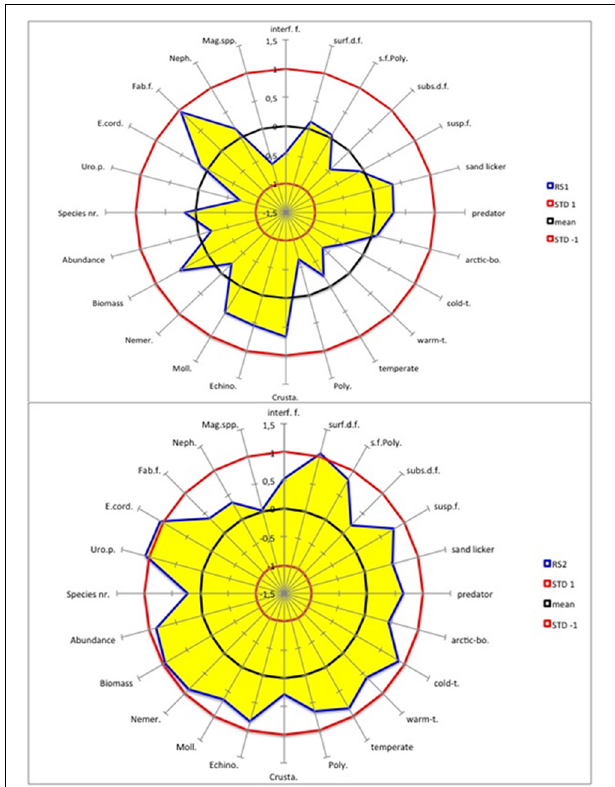
FIGURE 4 | AMOEBA model for the southern North Sea benthos (blue line as the edge of the yellow area). Two regime shifts (RS) are shown. RS1 shows the differences in the standardized spring values of the regime 1989–2000minus those of 1977–1988 (upper panel) . RS2 shows the differences in the standardized spring values of the regime 2001–2012minus those of 1989–2000 (lower panel) . The black circle marks the long-term climatic mean value, and the two red circles the ± 1 STD. The acronyms are in clockwise direction: Interface-feeders (interf.f.), surface-deposit-feeders (surf.d.f.), sediment-feeding polychaeta (s.f.Poly.), subsurface-deposit-feeders (subs.d.f.), suspension-feeders (susp.f.), arctic-boreal (arctic-bo.), cold-temperate (cold-t.), warm-temperate (warm-t.), Polychaeta (Poly.), Crustacea (Crusta.), Echinodermata (Echino.), Mollusca (Moll.), Nemertini (Nemer.), Urothoe poseidonis (Uro.p.), Echinocardium cordatum (E.cord.), Tellina (Fabulina) fabula , (Fab.f.), Nephtyidae spp. (Neph.), and Magelona spp. (Mag.spp.).